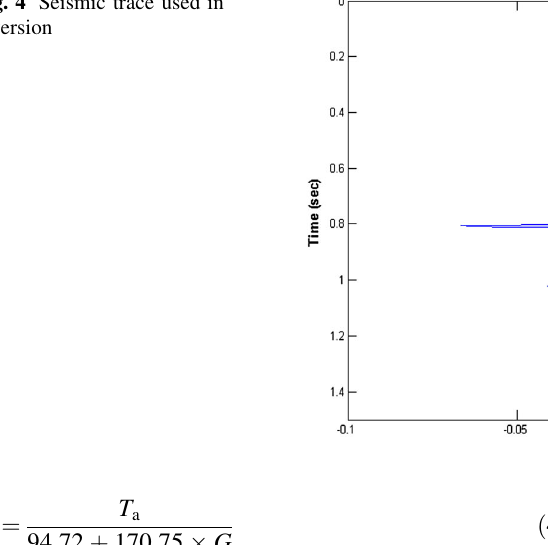
Fig. 3 Synthetic seismic model of three layers geological model Fig. 4 Seismic trace used